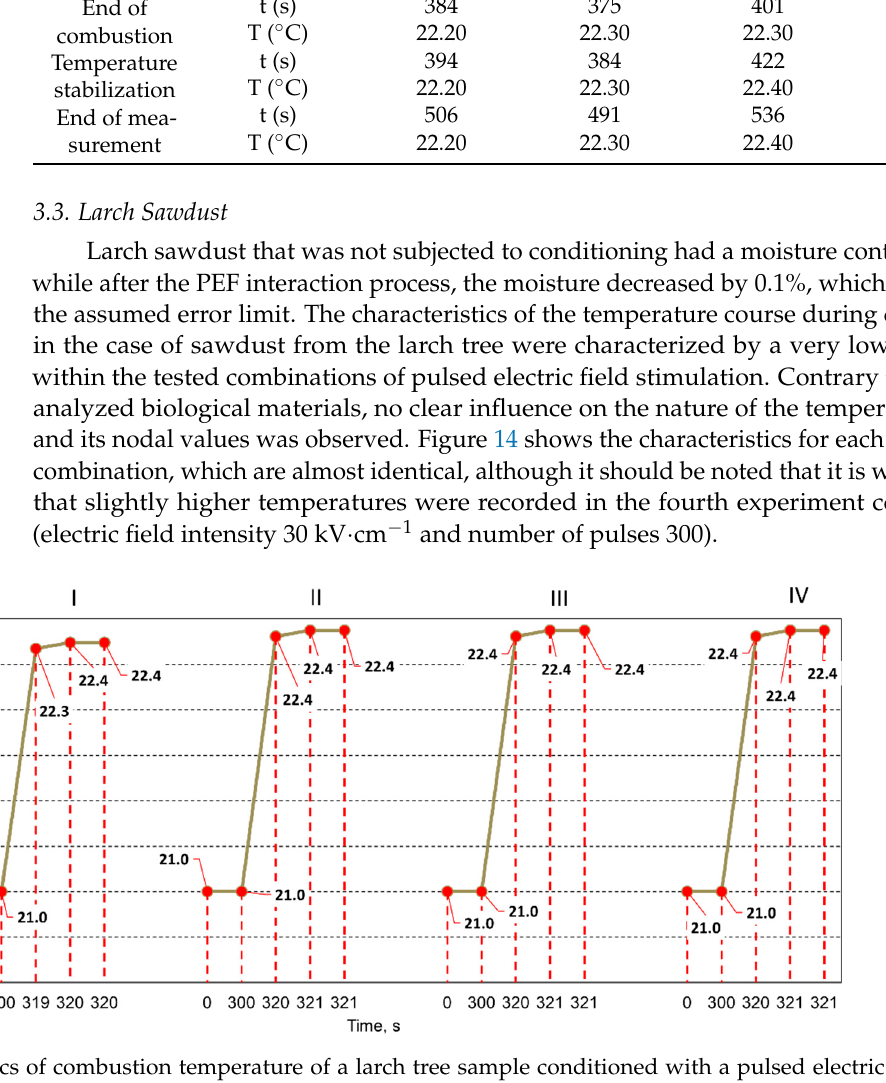
Table 3. Characteristic temperature points of larch sawdust combustion. Point